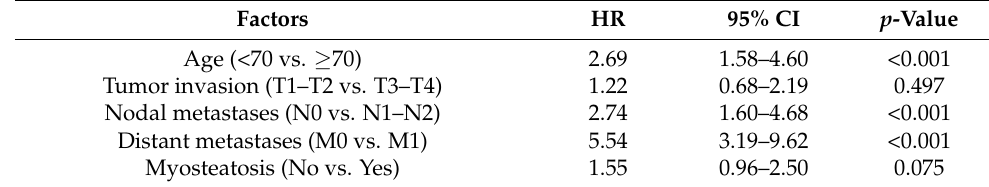
Figure 3. Kaplan–Meier survival curves for ( A ) the presence of myosteatosis and overall survival, ( B ) the presence of myosteatosis and sarcopenia and disease-free survival, ( C ) the presence of myosteatosis and sarcopenia and overall survival, and ( D ) the presence of myosteatosis and sarcopenia and cancer-specific survival. Table 6. Multivariable Cox regression model for overall